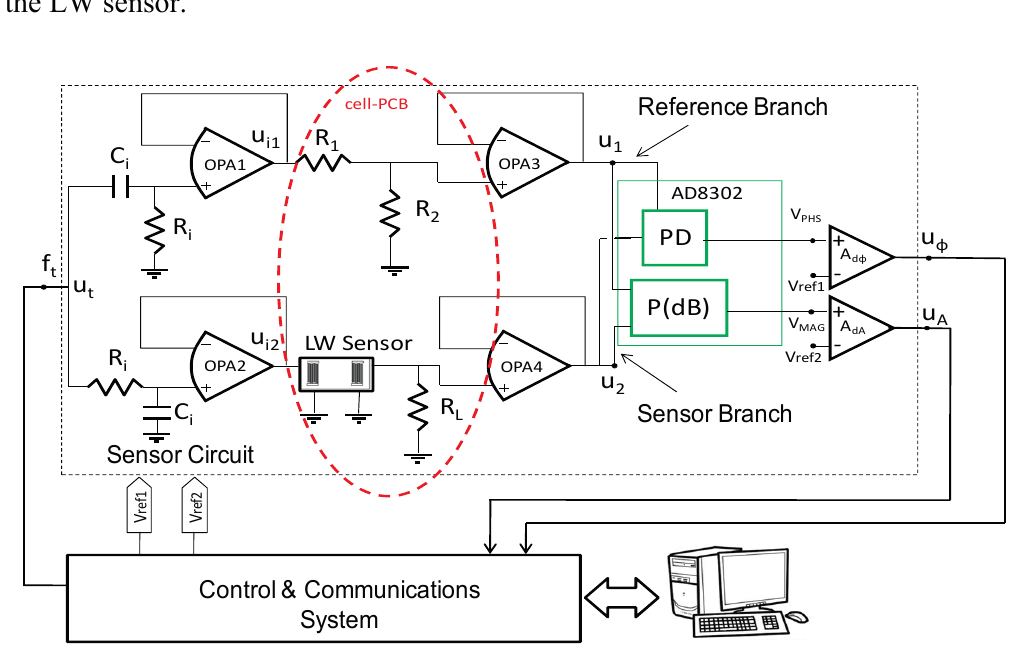
Figure 3. Schematics of the phase and amplitude electronic characterization system employed for the LW